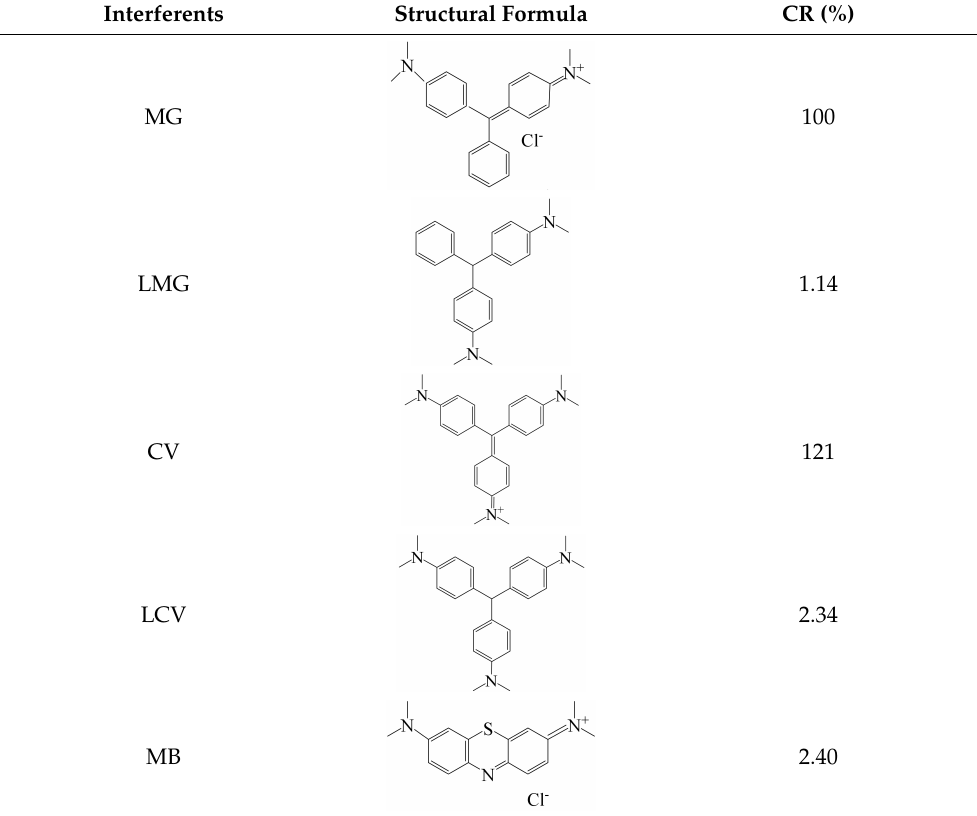
Table 1. Specificity of the ratiometric fluorescence immunoassay for the detection of MG.